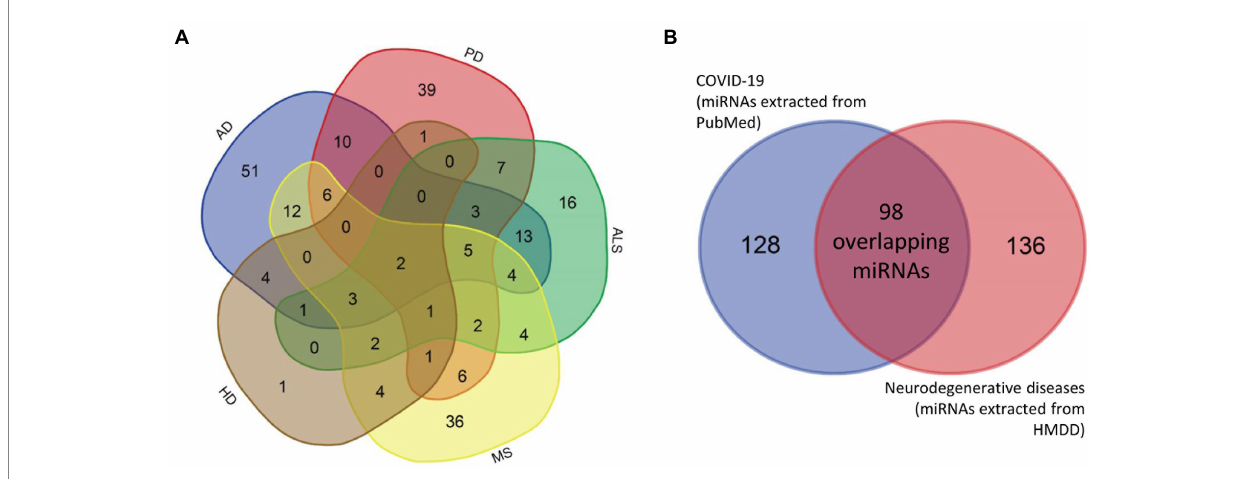
FIGURE 2 Venn diagrams. Venn diagrams showing the overlap between miRNAs associated with different neurodegenerative diseases separately (A) and the overlap between miRNAs associated with at least one neurodegenerative disease and COVID-19 (B) . AD, Alzheimer’s disease; ALS, amyotrophic lateral sclerosis; COVID-19, coronavirus disease 2019; HD, Huntington’s disease; MS, multiple sclerosis; PD, Parkinson’s disease.